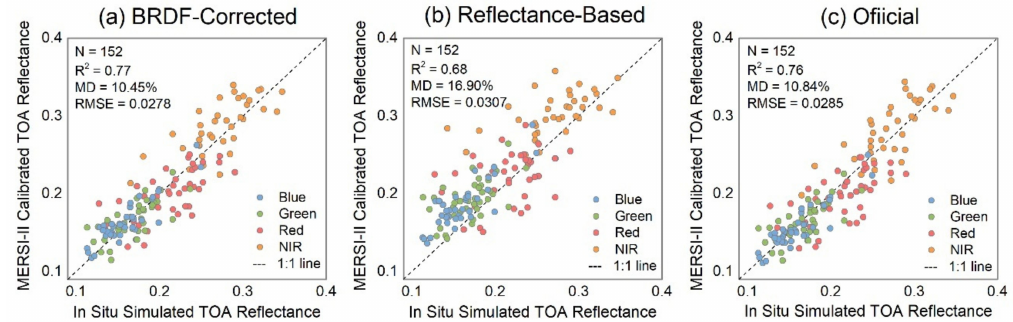
Figure 8. Validation of calibrated TOA reflectance of FY-3D MERSI-II using in-situ measurements simulated TOA reflectance for the four spectral bands: ( a ) the results for calibration coefficients derived using the proposed BRDF-corrected method; ( b ) the results for calibration coefficients derived using the reflectance-based method; ( c ) the results for official calibration coefficients. The statistical results of mean relative difference (MD), root mean squared error (RMSE), and the number of samples are also provided.